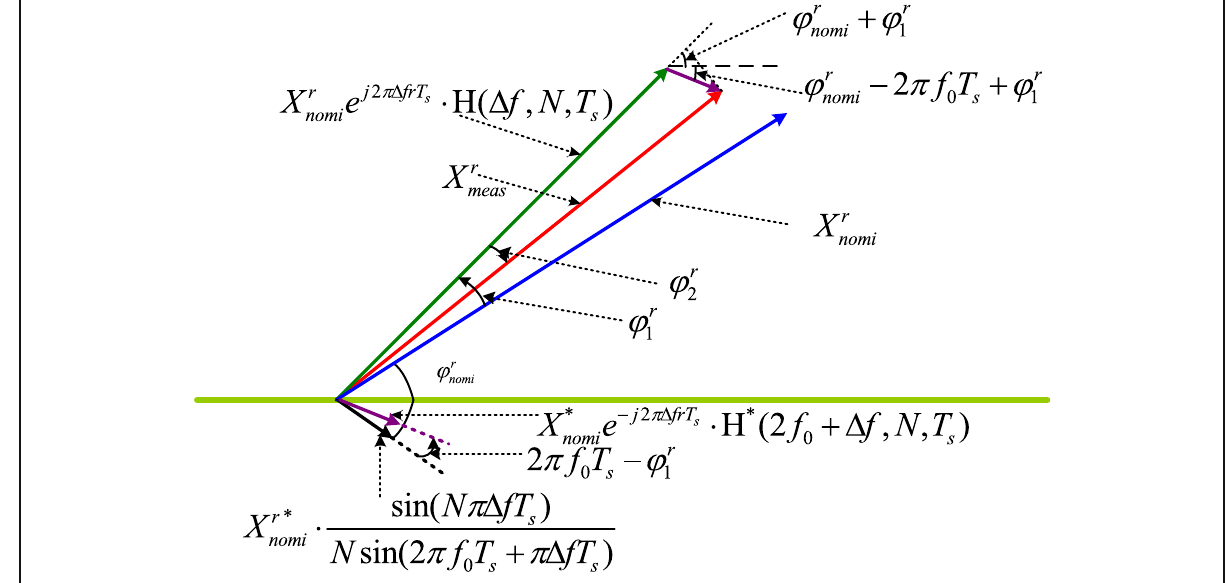
Fig. 2 Relationship of measured phasor and the nominal